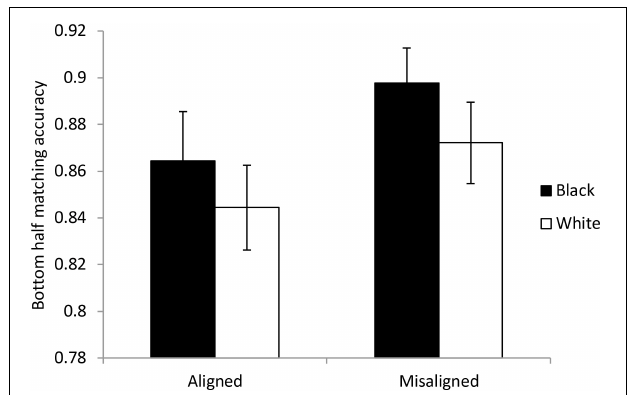
FIGURE 8 | The results of Experiment 2 displayed to illustrate the complete design or the congruence design. The points show the means of the discrimination measures from the signal detection analyses for each participant based on correctly identifying that the bottoms of the images were the same. The error bars show ± one standard error. A higher accuracy score represented better overall performance for detecting differences and determining when the mouth and nose were the